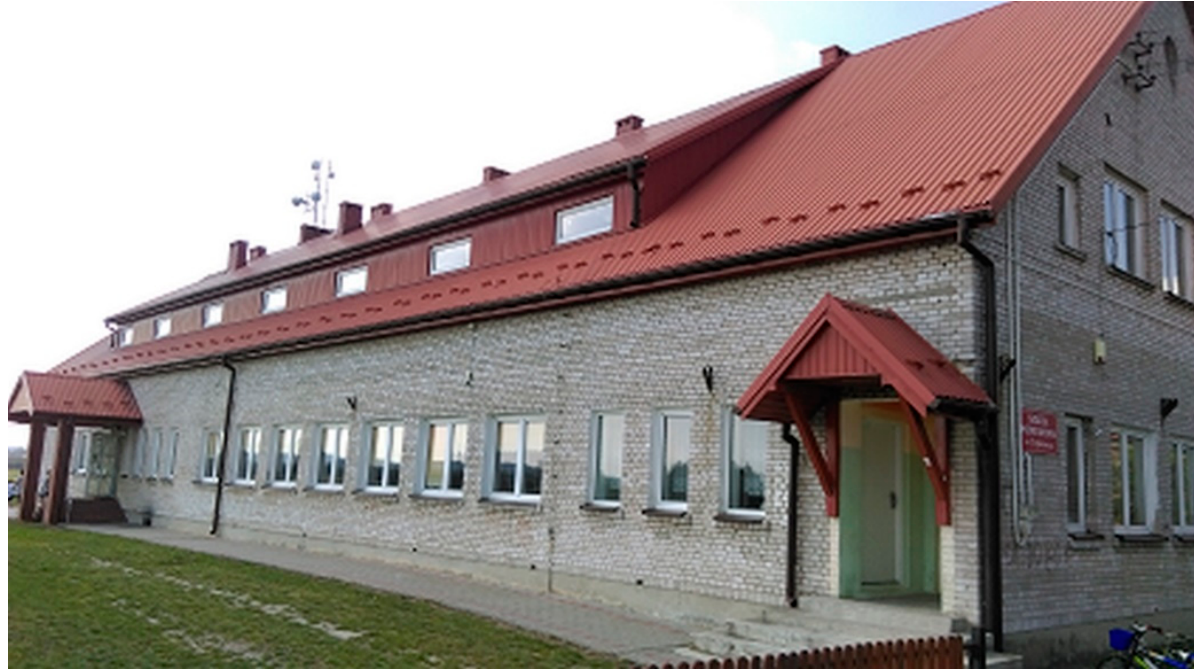
Figure 2. External view of the school before modernization.